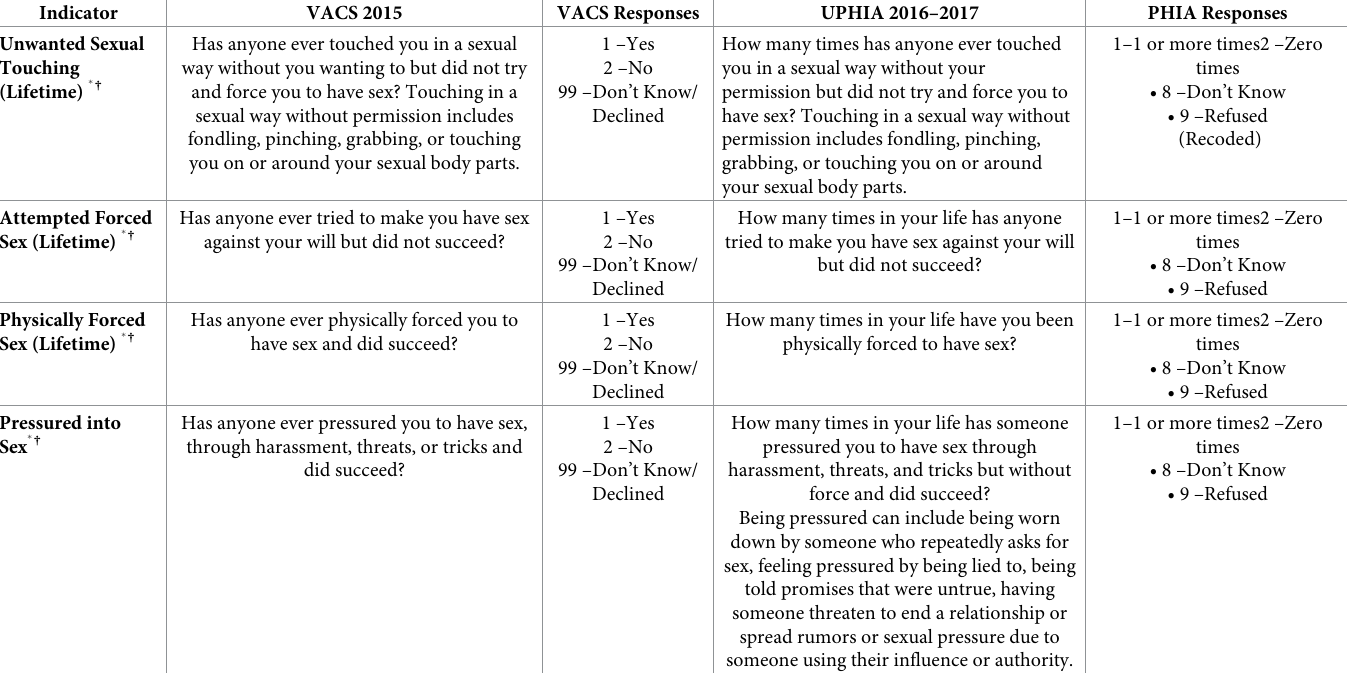
Weighted prevalence estimates and 95% confidence intervals (CI) were calculated stratified by gender, accounting for the complex sampling design of each survey. Comparisons between UPHIA and VACS were restricted to individuals aged 15–24 years so that comparisons included identical age groups. Two proportion z-tests were used to calculate p-values compar- ing prevalence estimates between VACS and UPHIA, with statistical significance determined at p < 0.05. Analyses were completed using SAS